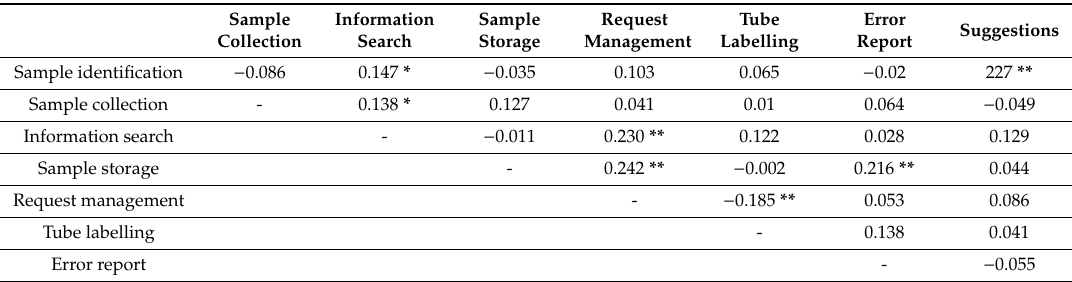
Table 3. Matrix of correlations between the di ff erent factors of the VBSQ scale. (Source: